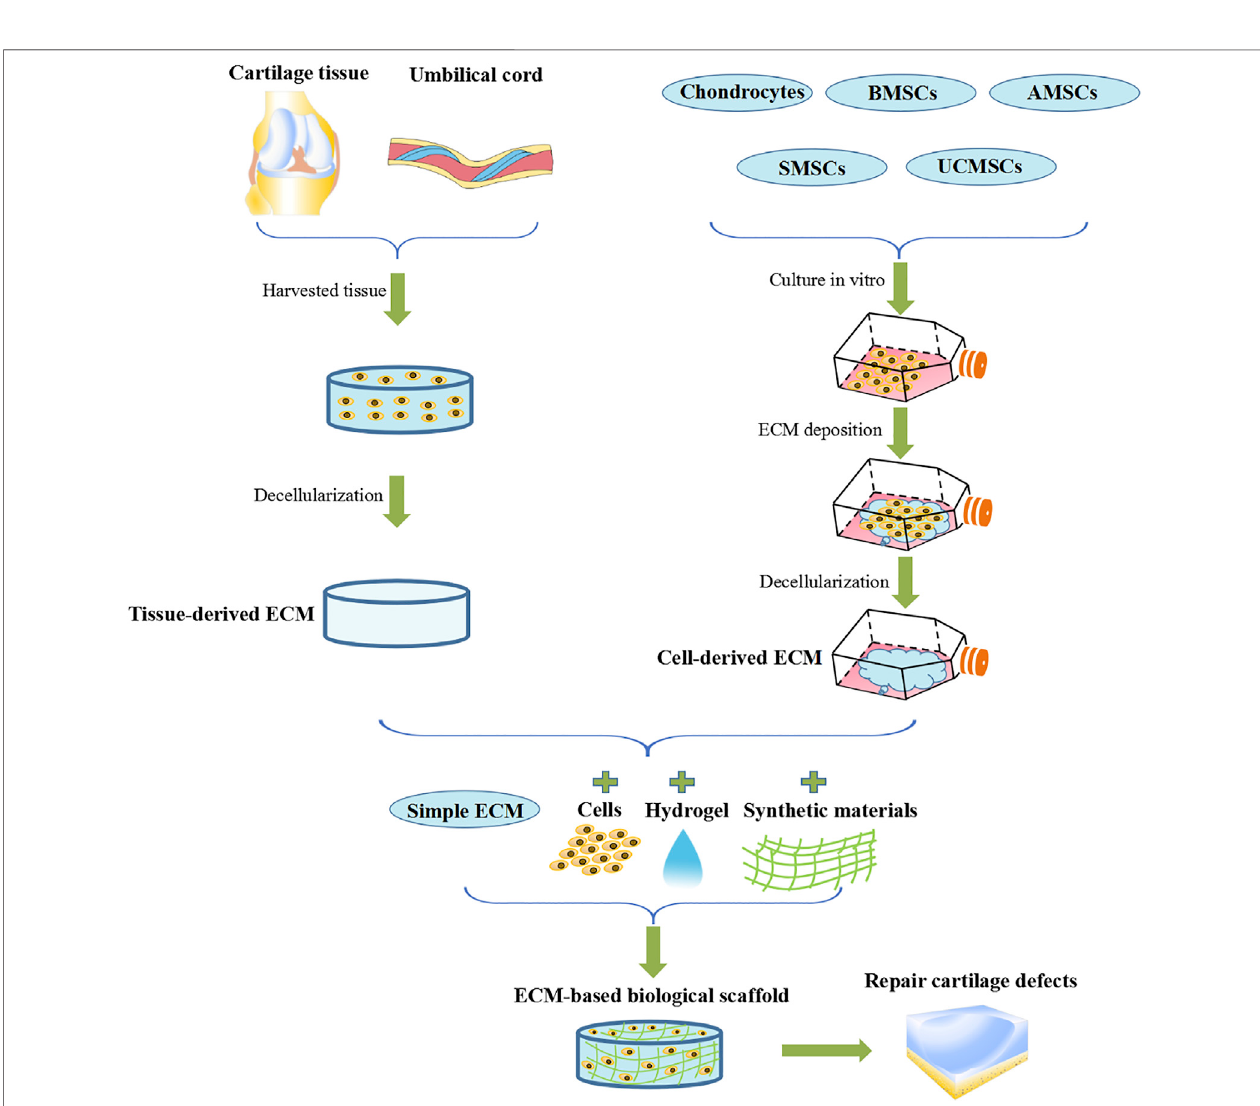
FIGURE 1 | ECM-based biological scaffolds for AC defect